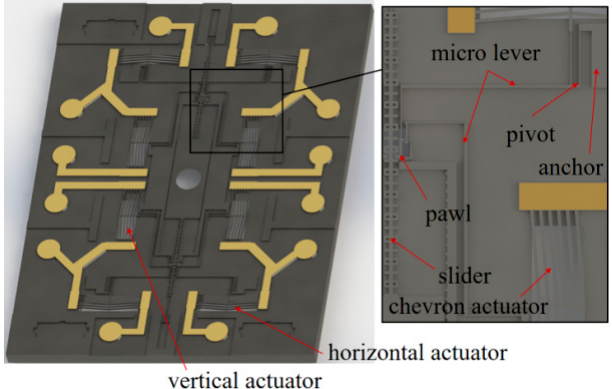
Figure 3. The structure of S&A chip. The interrupter is driving by the relative movement between the pawl and each tooth on the slider.